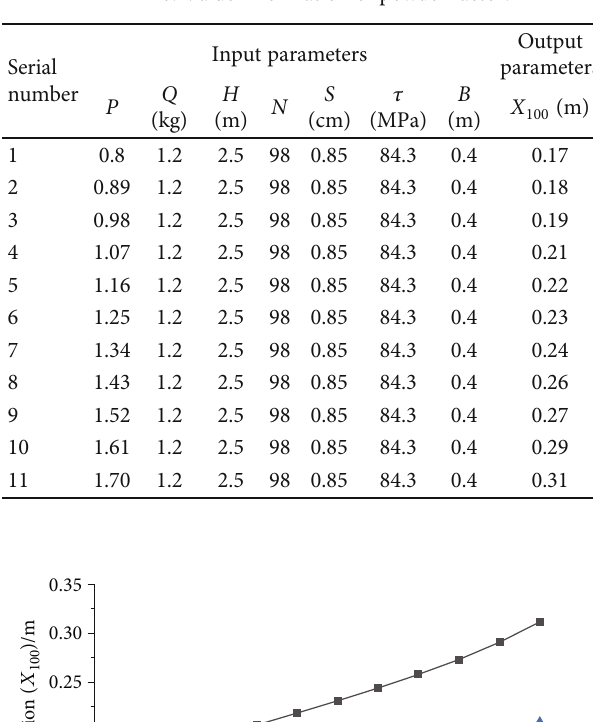
Table 6: Value information of powder